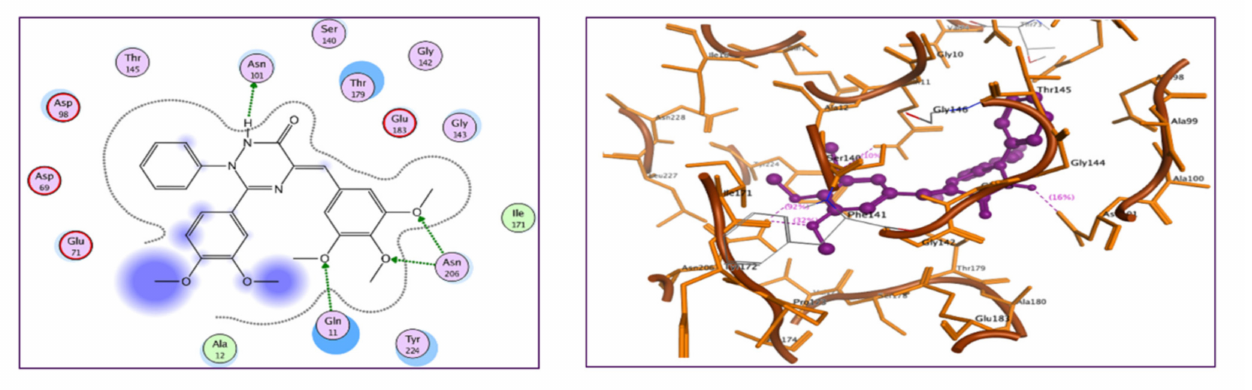
Figure 7. The binding poses (2D and 3D) of N -phenyl triazinone 9 in tubulin active site (PDB ID: